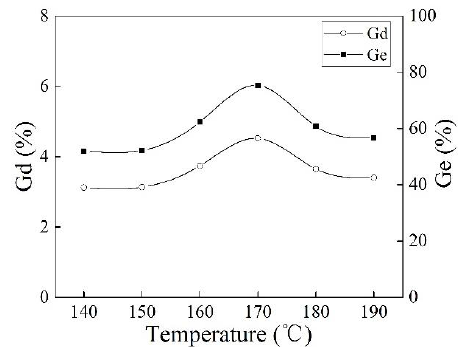
Figure 4. Effect of reaction temperature on Gd and Ge of iPB-g-MAH.